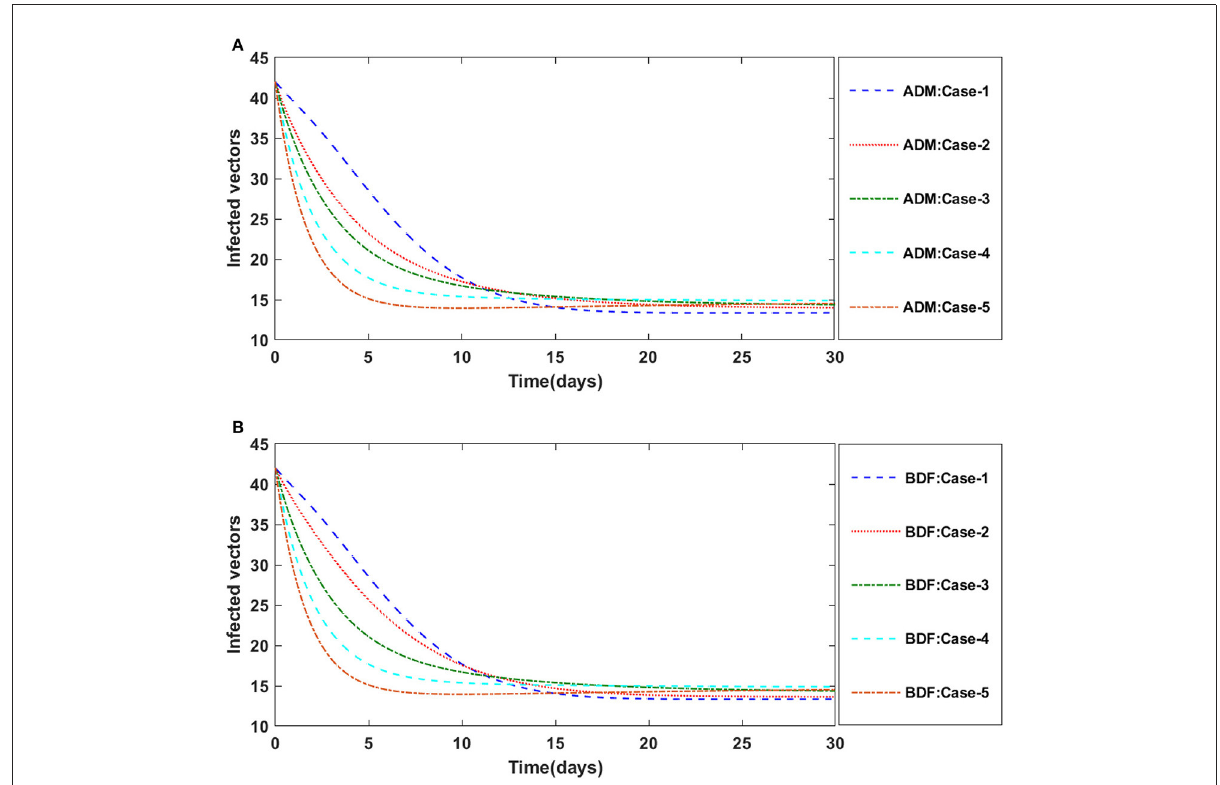
FIGURE25 (A) Dynamics of infected vectors for the varition in r using ADM for model B2. (B) Dynamics of infected vectors for the varition in r using BDF for model